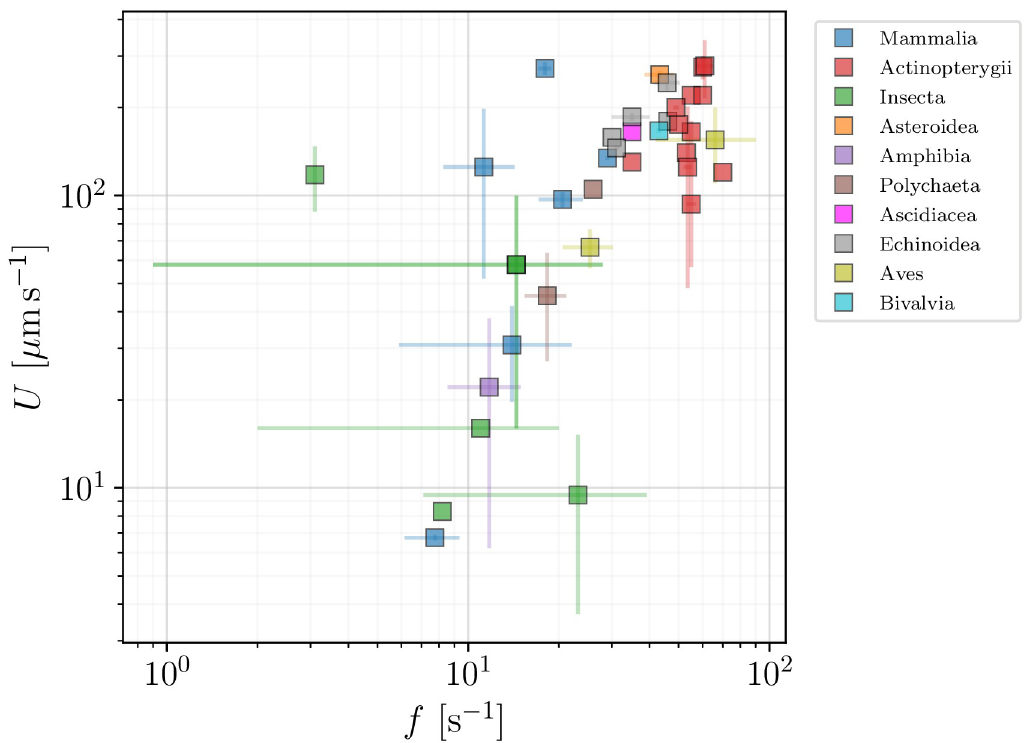
Fig 16. Swimming speeds, U ( μ m s − 1 ), as function of flagellar beat frequency f (s − 1 ), for spermatozoa. A strong correlation between U and f is apparent on the